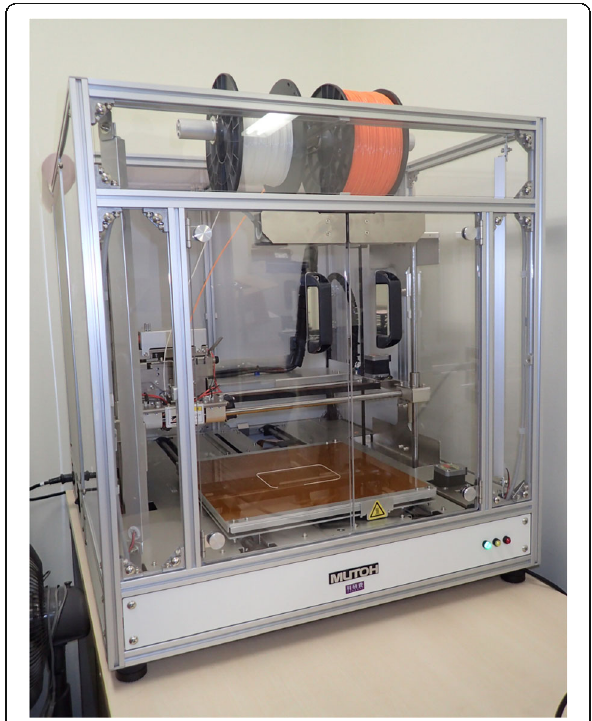
Fig. 4 Desktop FDM 3D printer “ Value3D MagiX MF-2000